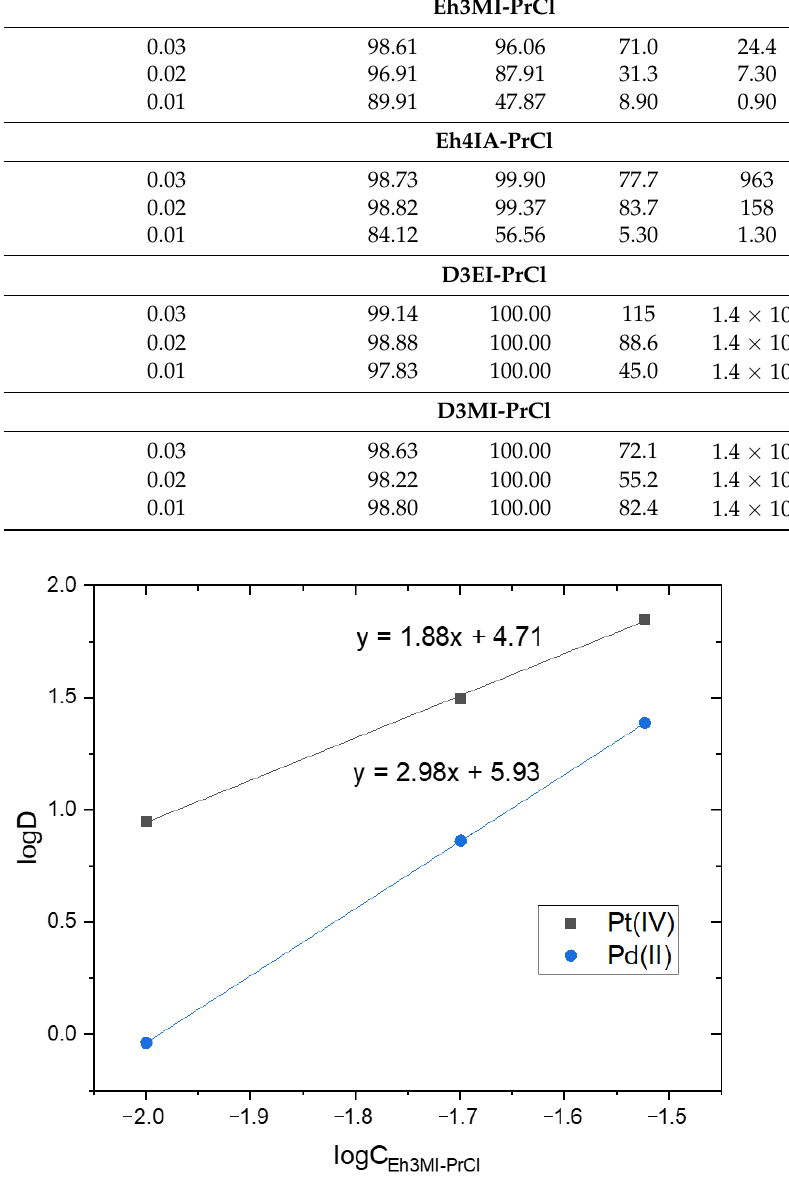
Table 9. Results of extraction from equimolar mixture of Pd(II) and Pt(IV) with selected extractants (A/O = 1, 20 min, feed:1.25 × 10 − 3 M Pd(II), 1.25 × 10 − 3 M Pt(IV) in 1 M HCl, organics: 5 × 10 − 3 M extractant in toluene). Extractant Concentration, M